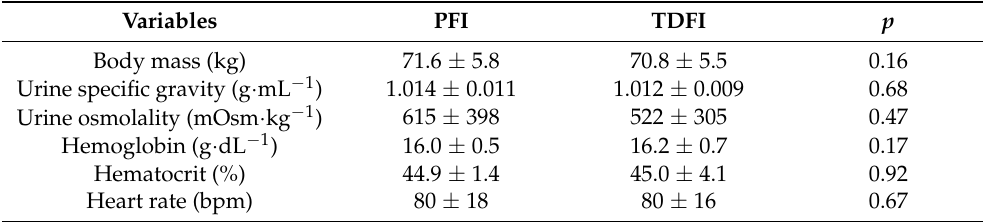
Table 1. Pre-exercise body mass, urine specific gravity, urine osmolality, hemoglobin level, hematocrit and heart rate for the programmed (PFI) and thirst-driven fluid intake (TDFI) strategies. Data are means ± SD. Variables